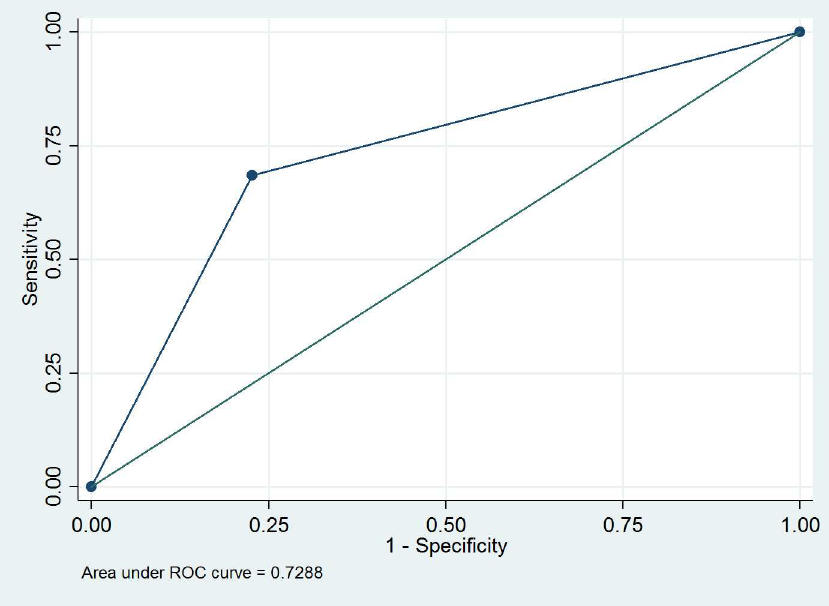
Fig 1. ROC curve for SmartNet detection of bednet state using participant diaries as